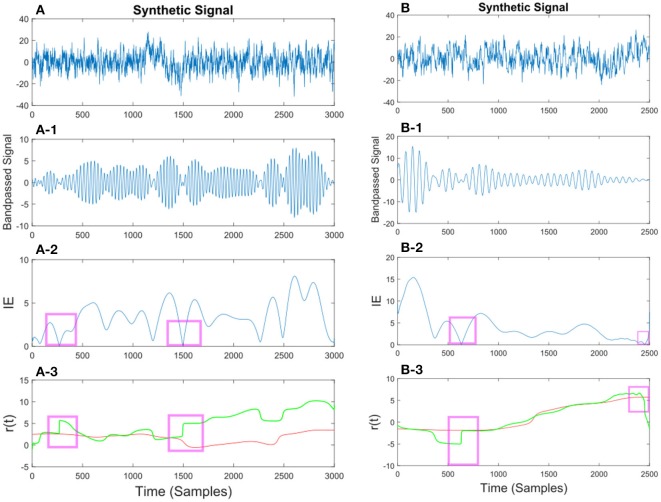
(A) Synthetic EEG signal generated at a fs = 250Hz with a SNR of 0.11 (high noise variance) bandpassed at fc = 7.6 Hz. Different noise amplitudes have been used for the two examples. The instantaneous envelope (IE) has been plotted with red boxes showing the regions with a low envelope below 0.2. In the last plot the resulting r(t) has been plotted for the smoothed (red) and non-smoothed (green) signal. The red regions show the effect of the smoothing on the regions with a low IE. (B) Same description as in (A) applies to (B) with a SNR of 0.13.